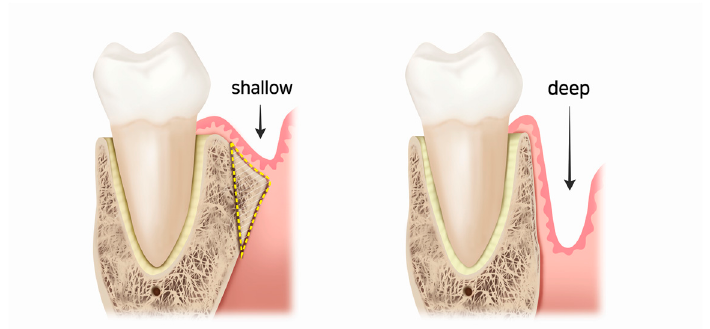
Figure 3. Drawings of mandibular molars and their mesiodistal supporting structures. The vestib- ular fornix becomes deeper by reducing the buccal cortical plate.